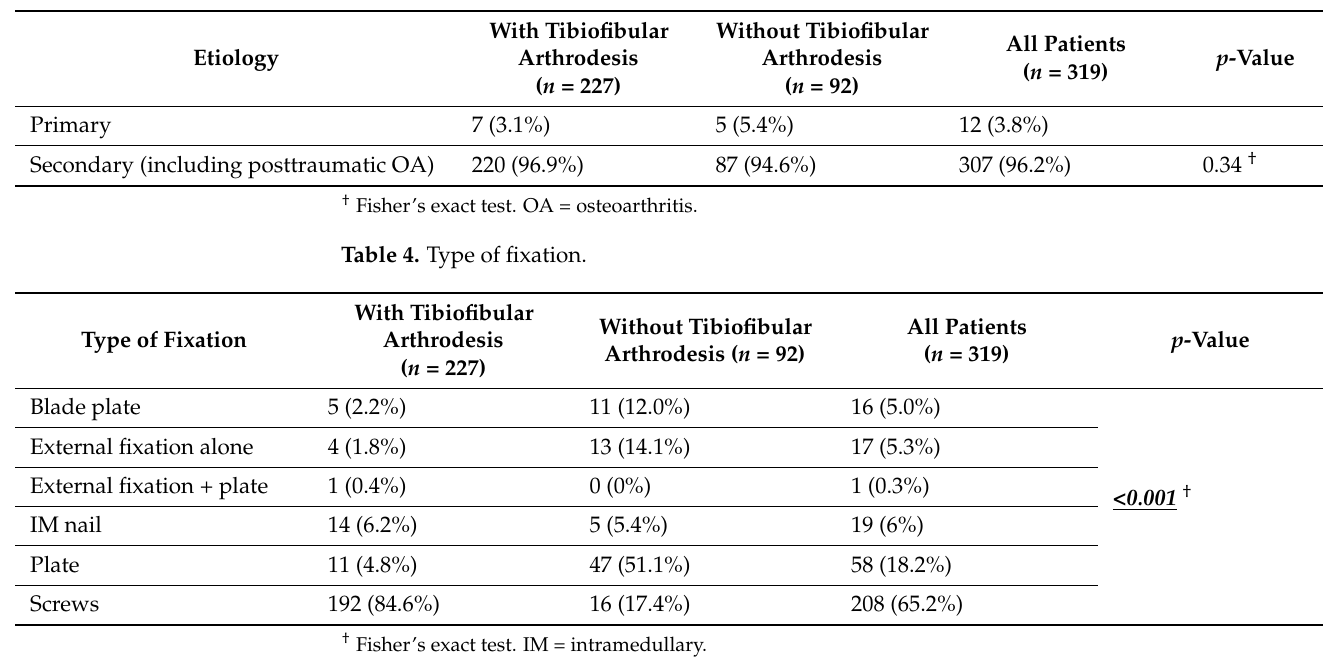
Table 3. Etiology of tibio-talar arthritis.